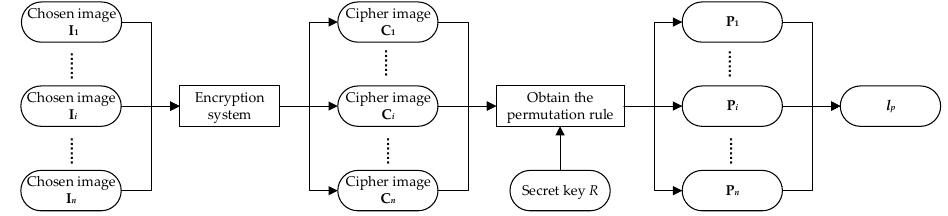
l . Figure 4. Flowchart on obtaining the permutation rule l p p